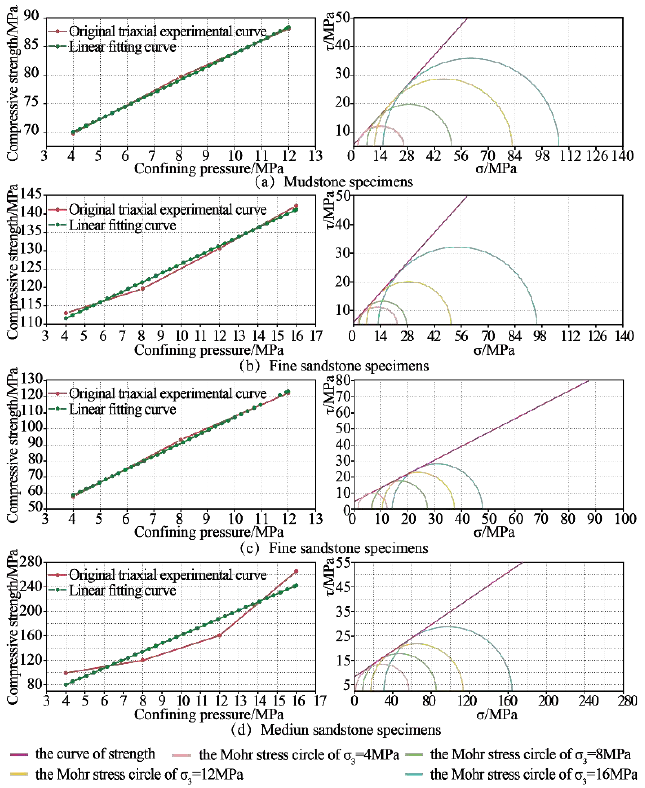
Figure 11. Triaxial test curve of mudstone, triaxial test curve of fine sandstone, triaxial test curve of fine sandstone, and triaxial test curve of medium sandstone.